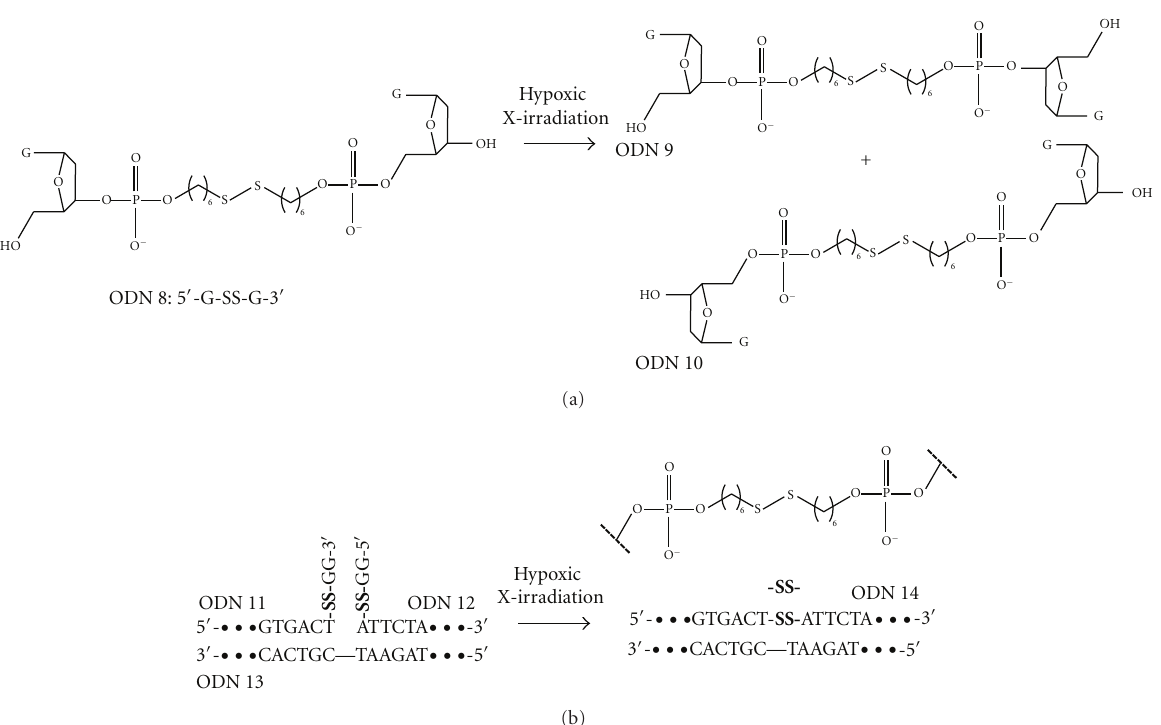
Figure 6: (a) Radiolytic strand exchange reaction of dinucleotide unit possessing disulfide bond. (b) Radiolytic template-directed ligation of oligodeoxynucleotides possessing disulfide bond.